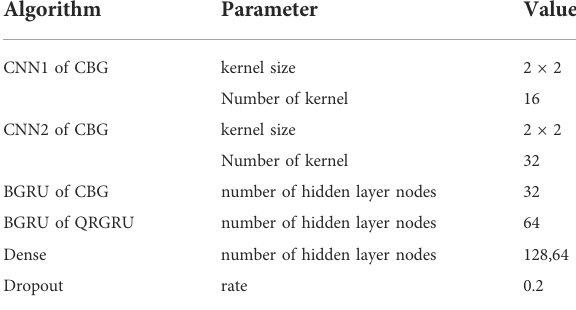
TABLE 2 The main parameter settings of VMDS-QR-CBG.